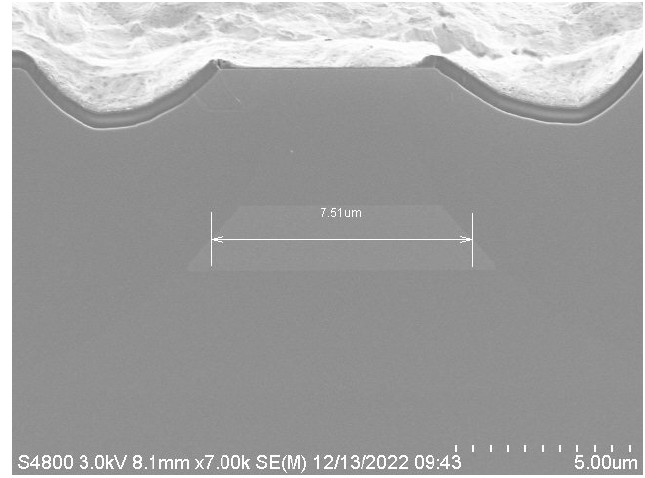
Figure A1. SEM picture of the laser cross